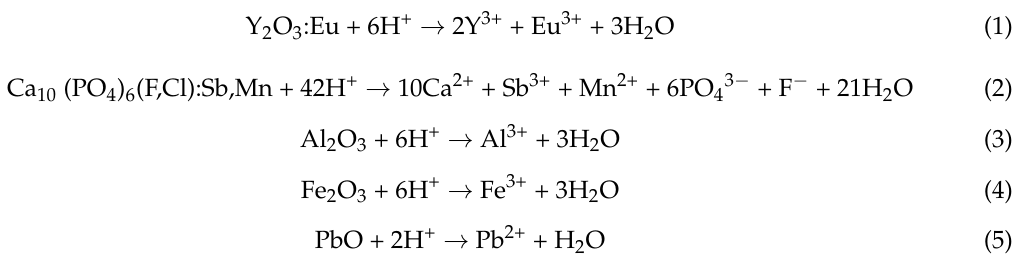
Table 2. Inductively coupled plasma (ICP) emission spectroscopy analysis of the dissolved solution by leaching 20 g waste fluorescent powder.